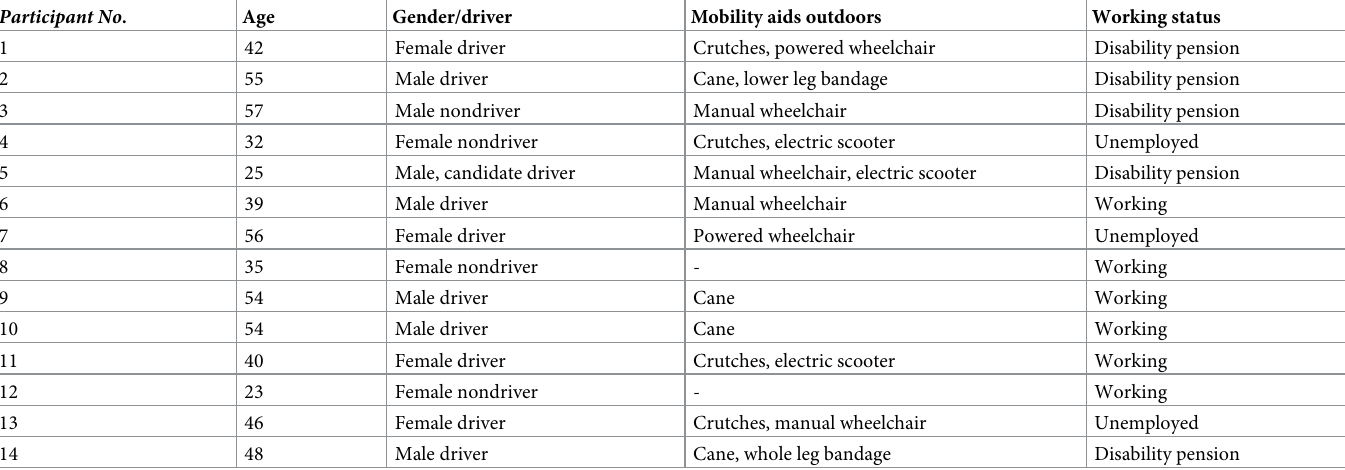
Table 2. Participants characteristics (n = 14).